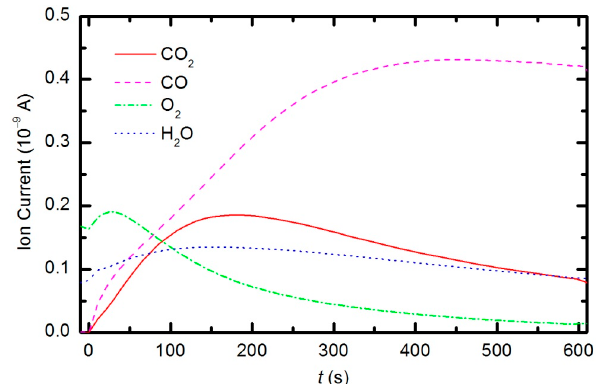
Figure 15. Time evolution of CO 2 , CO, O 2 and H 2 O partial pressures during sample treatment with oxygen plasma at 33 Pa and 300 W forward RF power.